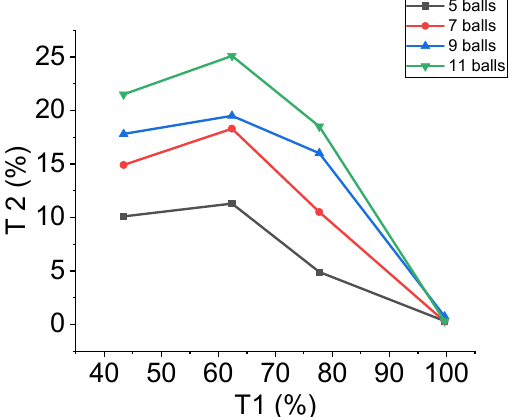
Figure 6. Mass fraction of middle size class (T2) against the mass fraction of the feed (T1) of the sample for different speeds.